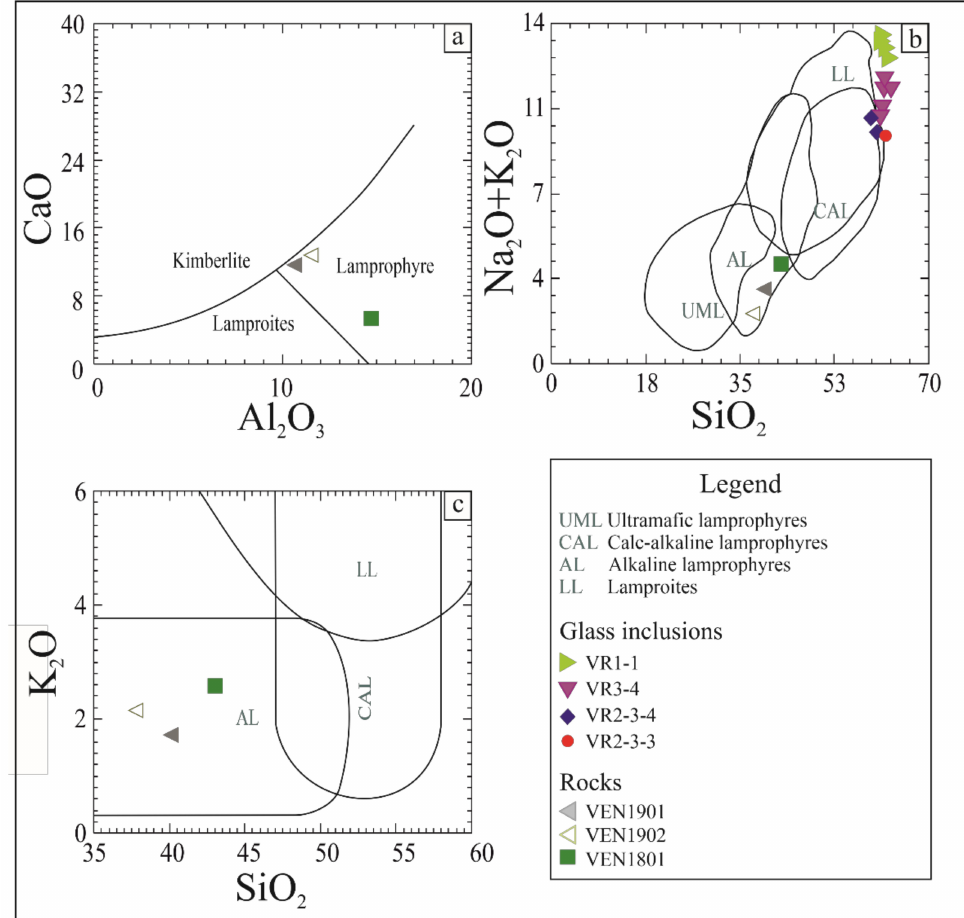
Figure 12. Binary diagrams illustrating the composition of the studied rocks and glass inclusions (Table 1). See text for regions. ( a ) CaO vs. Al 2 O 3 [35]; ( b ) Na 2 O + K 2 O vs. SiO 2 [36]; ( c ) K 2 O vs. SiO 2